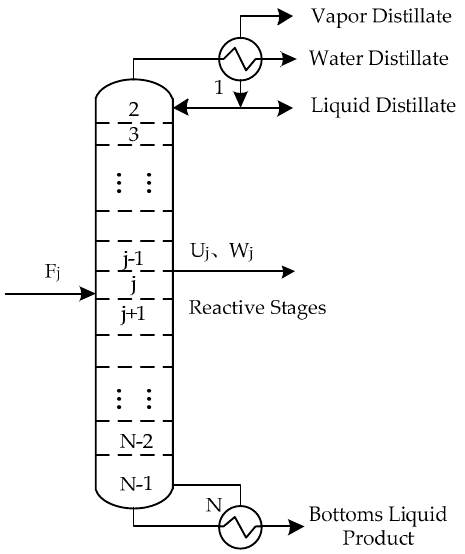
Figure 1. Schematic representation of the reactive distillation column.